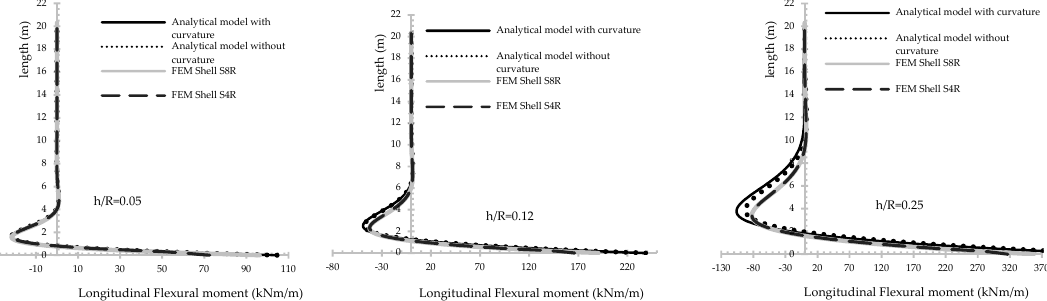
Figure 12. Longitudinal flexural moment for thin, medium and thick shells, considering different models.